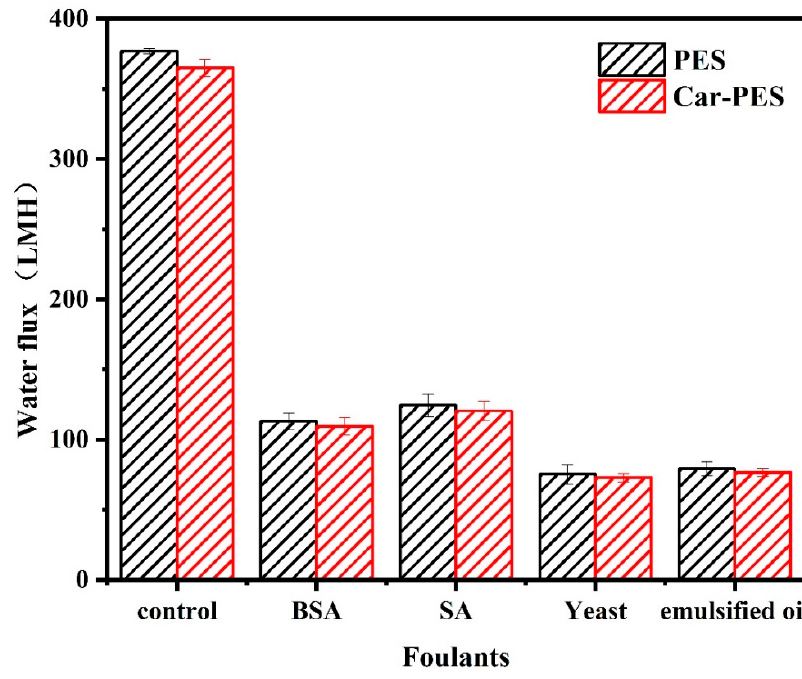
Figure 4. Water fluxes through PES and Car-PES membranes (conditions: (BSA) in = 10 mg / L, (SA) in = 10 mg / L, (yeast) in = 10 mg / L, (emulsified oil) in = 10 mg / L, (cross-flow velocity) = 6.1 cm / s, (time) = 60 min and (pressure) = 0.1 bar).